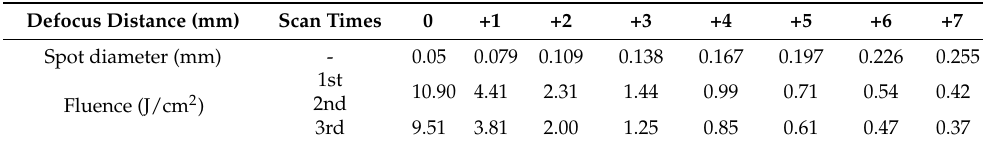
Table 4. Spot diameter, fluence and overlap rate at different defocus surfaces.